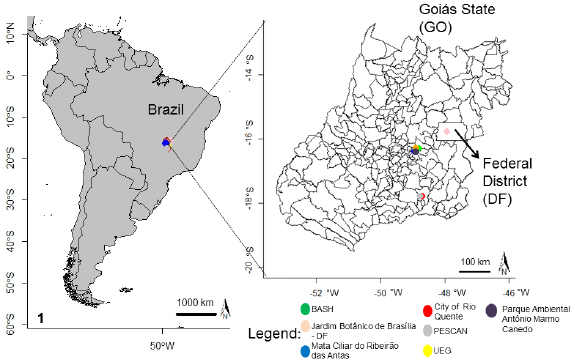
Figure 1. Distribution of the sites sampled in Goiás state and Fed- eral District. Map of South America, showing collection areas in Brazil (left), and Collection sites in Goiás state and Federal District. Maps produced with R